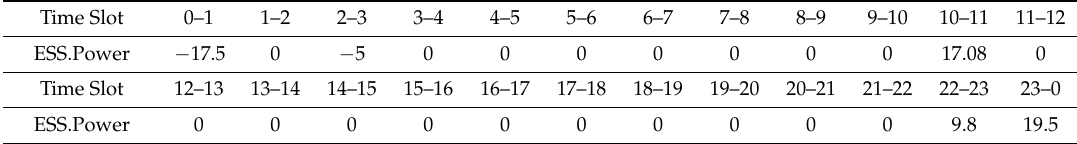
Table 4. The Hour-based ESS Operating Schedules.